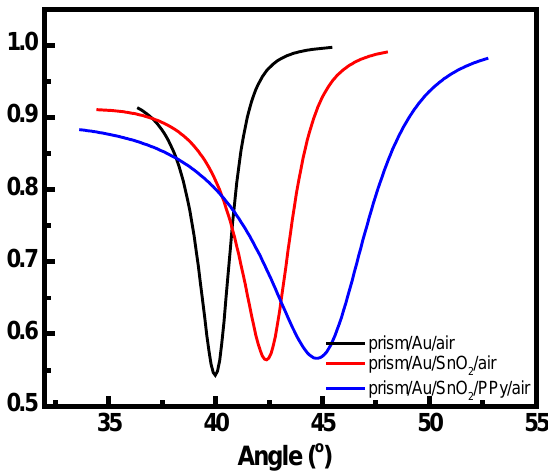
Figure 1. Theoretically simulated SPR reflectance curves for prism/Au/air, prism/Au/SnO 2 /air, and prism/Au/SnO 2 /PPy/air.